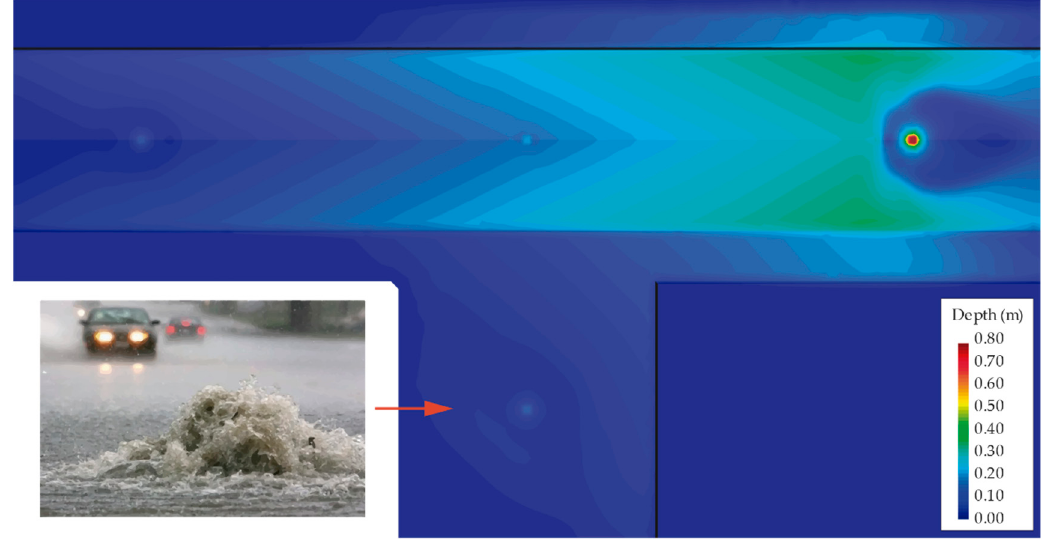
Figure 4. Results of depths and discharges at manholes and maximum water depth for manholes.